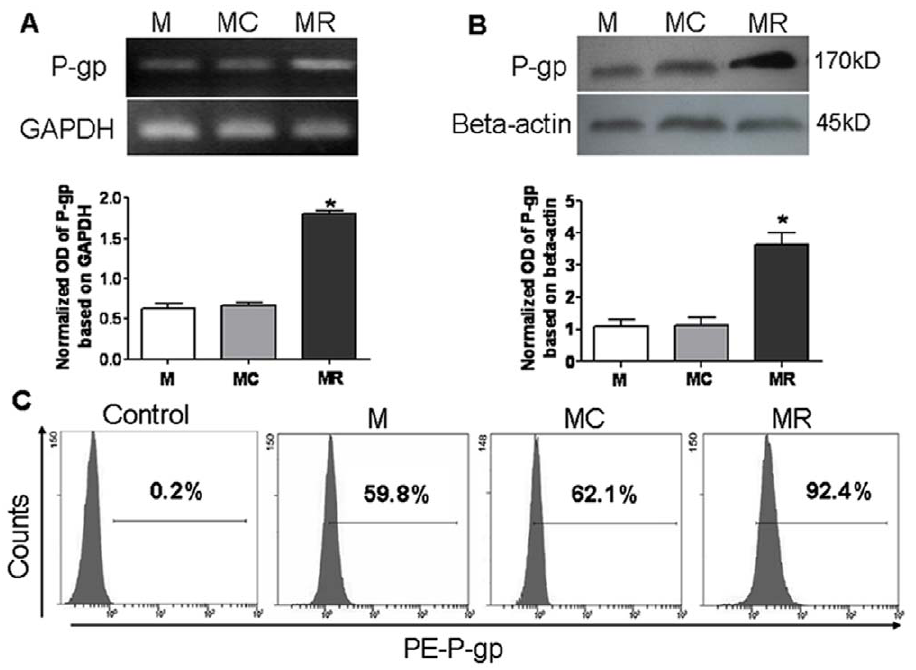
Figure 2. P-gp expression induced by CCL25 in MOLT4 cells. (A) RT-PCR and (B) Western blot analyses for P-gp expression induced by CCL25 in MOLT4 cells. MR cells were used as positive control. Amplification of GAPDH was used as control for RT-PCR assays. For loading control in western blot, membranes were incubated with monoclonal anti- b -actin antibody. (C). Expression of P-gp in cells stained with PE-anti-human MDR1 antibody by FCM. Values presented are the means of four independent experiments.